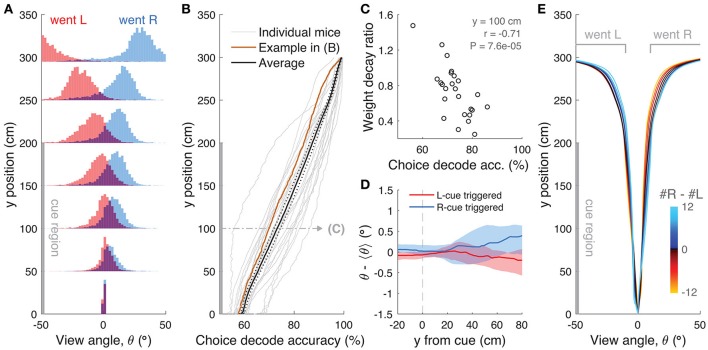
View angle trajectories. (A) Distribution of view angles in left and right choice trials (arbitrary units, normalized to equal area for both choice categories) for an example mouse, sampled at several y positions (0, 50, …, 250, 295 cm) along the stem of the T-maze. (B) Accuracy of decoding the eventual choice of a given mouse using a threshold on the view angle, evaluated at various y positions along the T-maze. (C) Scatter plot across mice of the evidence weight decay ratio (see Figure 3C) vs. the choice decoding accuracy evaluated at halfway into the cue region as indicated in (B). (D) Cue-triggered change in the view angle θ relative to the average trajectory <θ> for trials of the same choice. The bands indicate the 1 standard deviation spread across mice, with the thick lines being the median across mice. (E) Average view angle for subsets of left/right choice trials with various values of #R – #L (color code). For a given choice, the mean view angle trajectory of individual mice are aligned to the aggregate data (metamouse) before averaging.